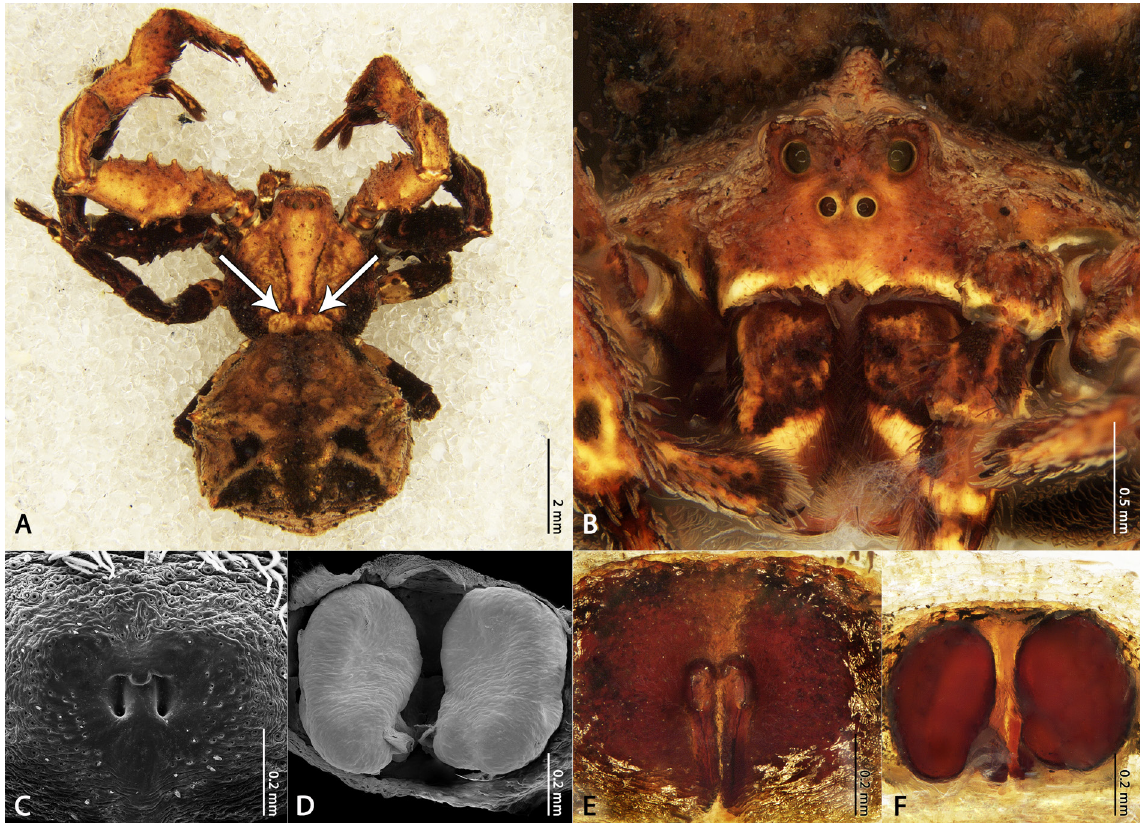
Fig. 3. Female of Kryptochroma gigas Machado & Viecelli gen. et sp. nov. Holotype (UFMG 4734). A . Habitus, dorsal view (arrows indicate the pair of circular taints on the posterior slope of the prosoma). B . Front. C, E . Epigynal plate, ventral view. D, F . Spermathecae, dorsal